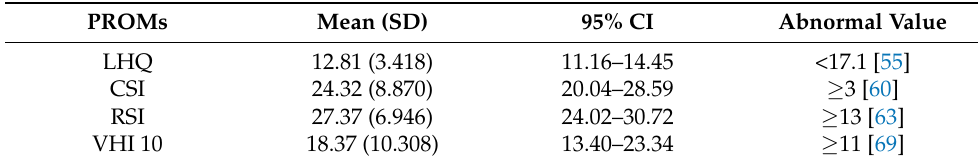
Table 6. Descriptive statistics of patient reported outcome measures at baseline.